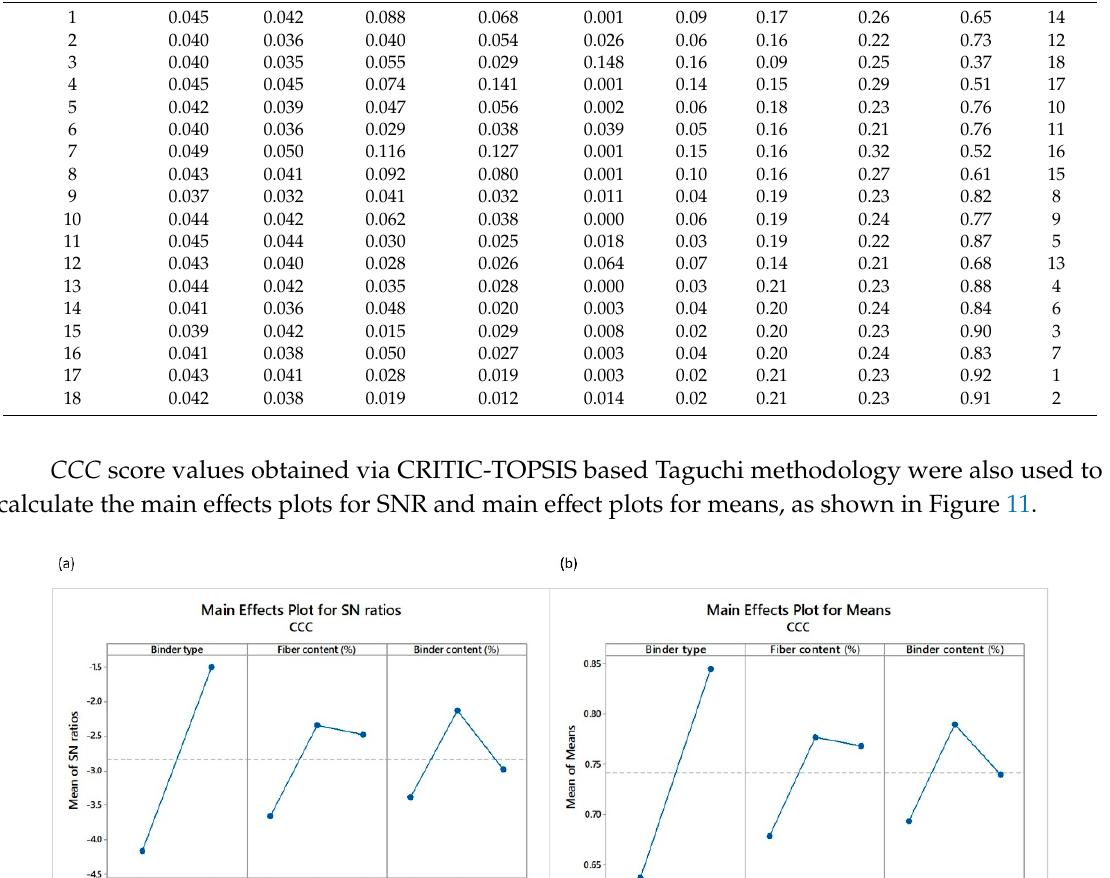
Table 11. Weighted normalized response, CCC values and final ranking.